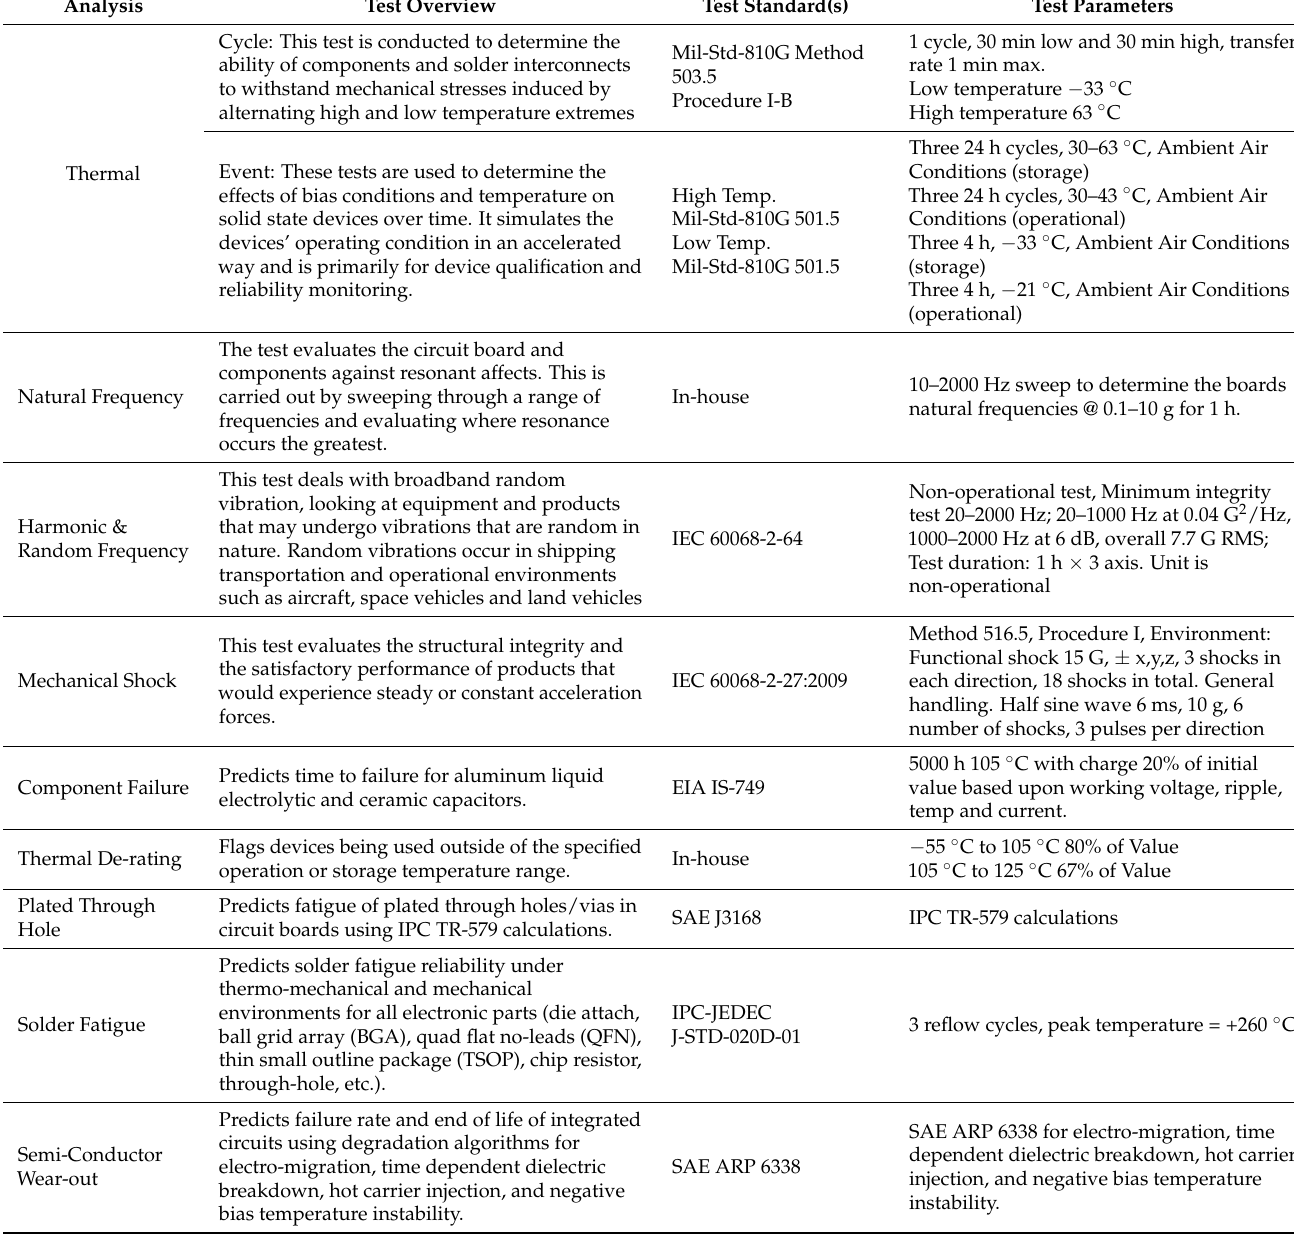
Table 2. Hypothetical test plan for PCB under